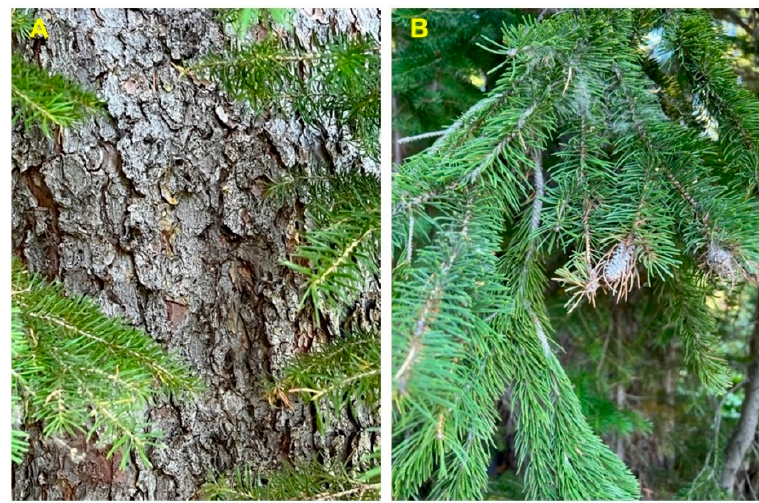
Figure 4. Picea engelmannii subsp. engelmannii from southern Idaho. ( A ): bark. ( B ): foliage. Photographs by K. Swor.